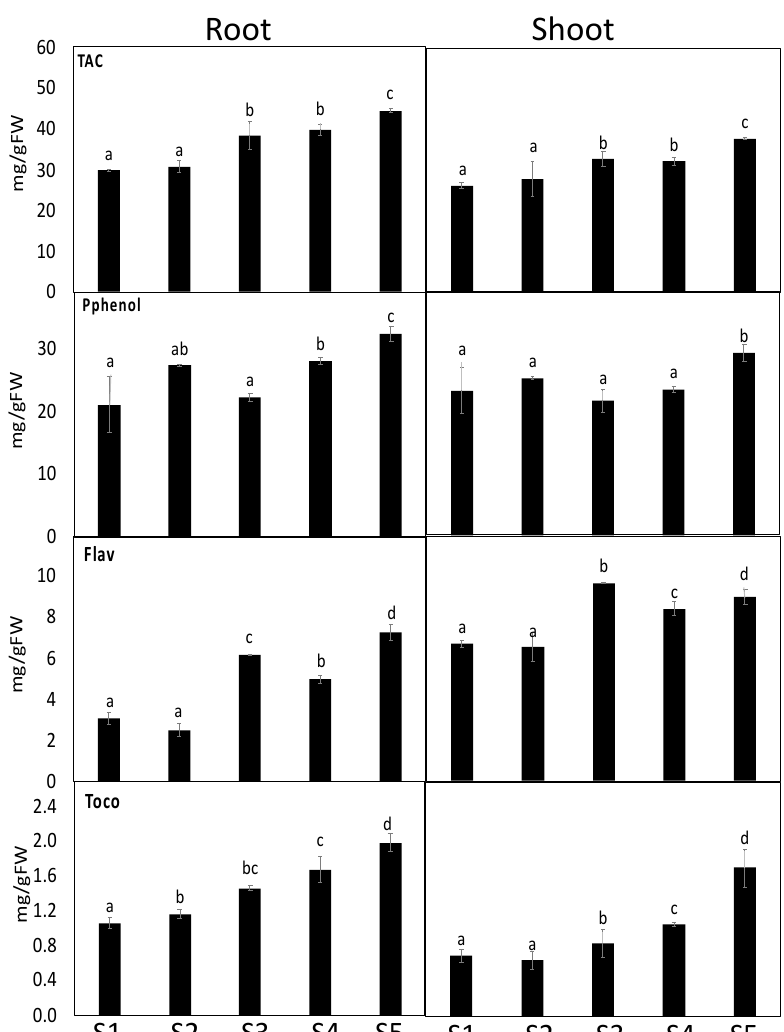
Figure 3. The impact of soil pollution on total antioxidant metabolites in the shoots and roots of S. portulacastrum. The changes in total antioxidant capacity (TAC, FRAP), polyphenols (Pphenol), flavonoids (Flav) and tocopherols (Toco) in S. portulacastrum grown in different control sites (site 5) and contaminated sites (sites 1–4). Data are mean values ± SD ( n = 4). Different letters (a–d) indicate statistically significant difference between means of the same plant species at significance level at least ( p ≤ 0.05).